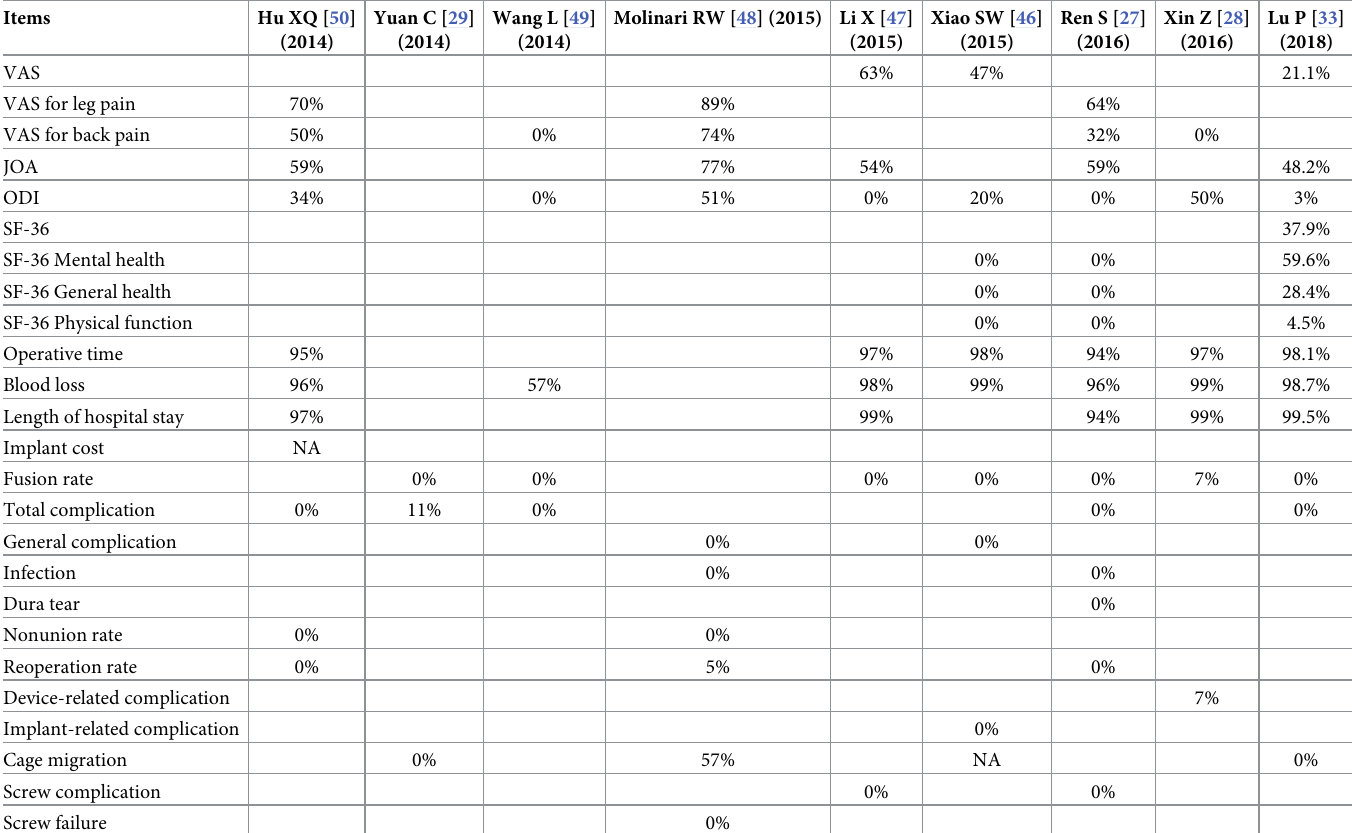
Table 6. I 2 statistic value of variables in each meta-analysis.